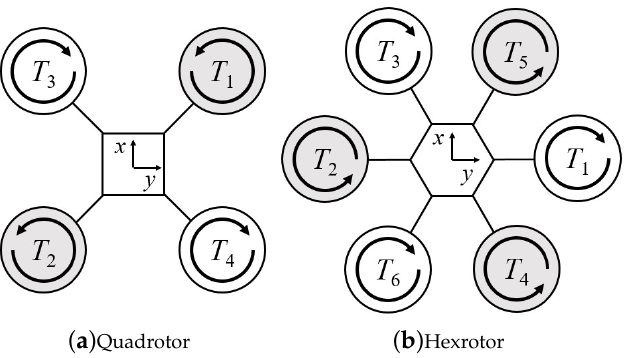
Figure 7. Top-down view of ( a ) quadrotor and ( b ) hexrotor models with propeller thrust pairs [( ω ) , ( ω ) , ( ω )] . Motors are indexed in the opposite direction starting from the T 3 , ω 4 5 , ω 6 1 , ω 2 motor, which generates thrust force T 1